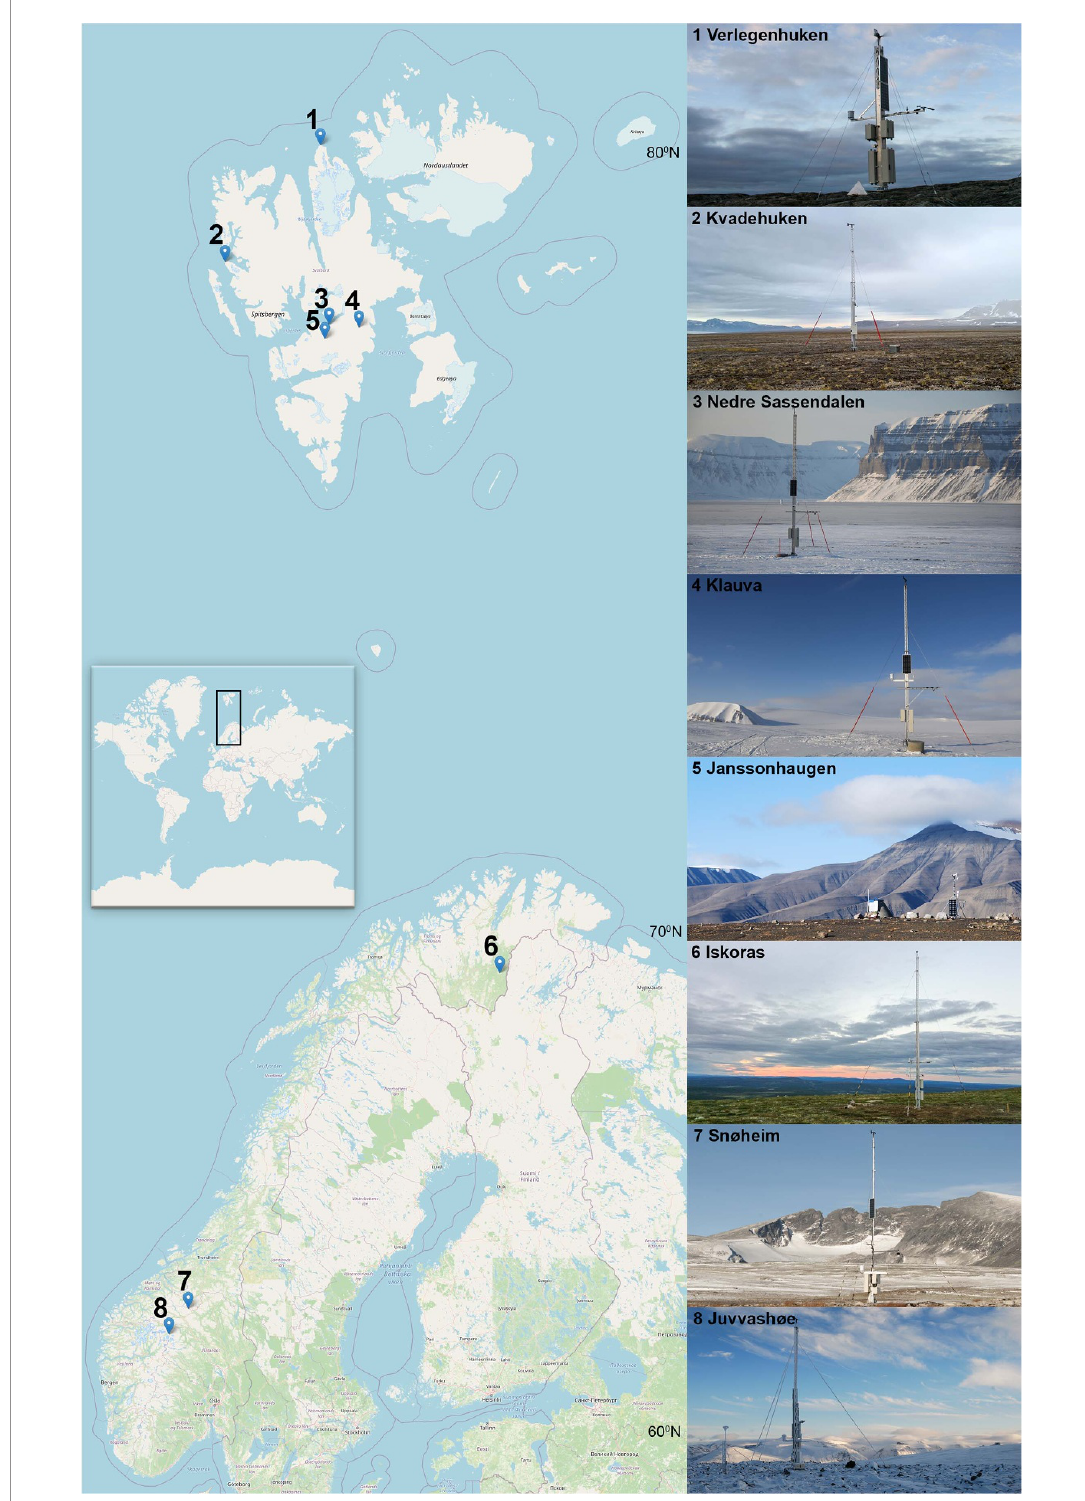
Figure 1. Location of the permafrost stations in Norway and Svalbard available on https://cryo.met.no/en/permafrost per August 2022. (Background map) Background map from https://cryo.met.no/ by Leaflet—© OpenStreetMap contributors. (1) Photo taken by Bernt Enge Larsen, MET Norway. CC BY 4.0. (2) Taken by Stein Tore Pedersen with permission. (3–5, 7–8) Photo taken by Ketil Isaksen, MET Norway. CC BY 4.0. (6) Photo taken by Tone Husebye, MET Norway. CC BY